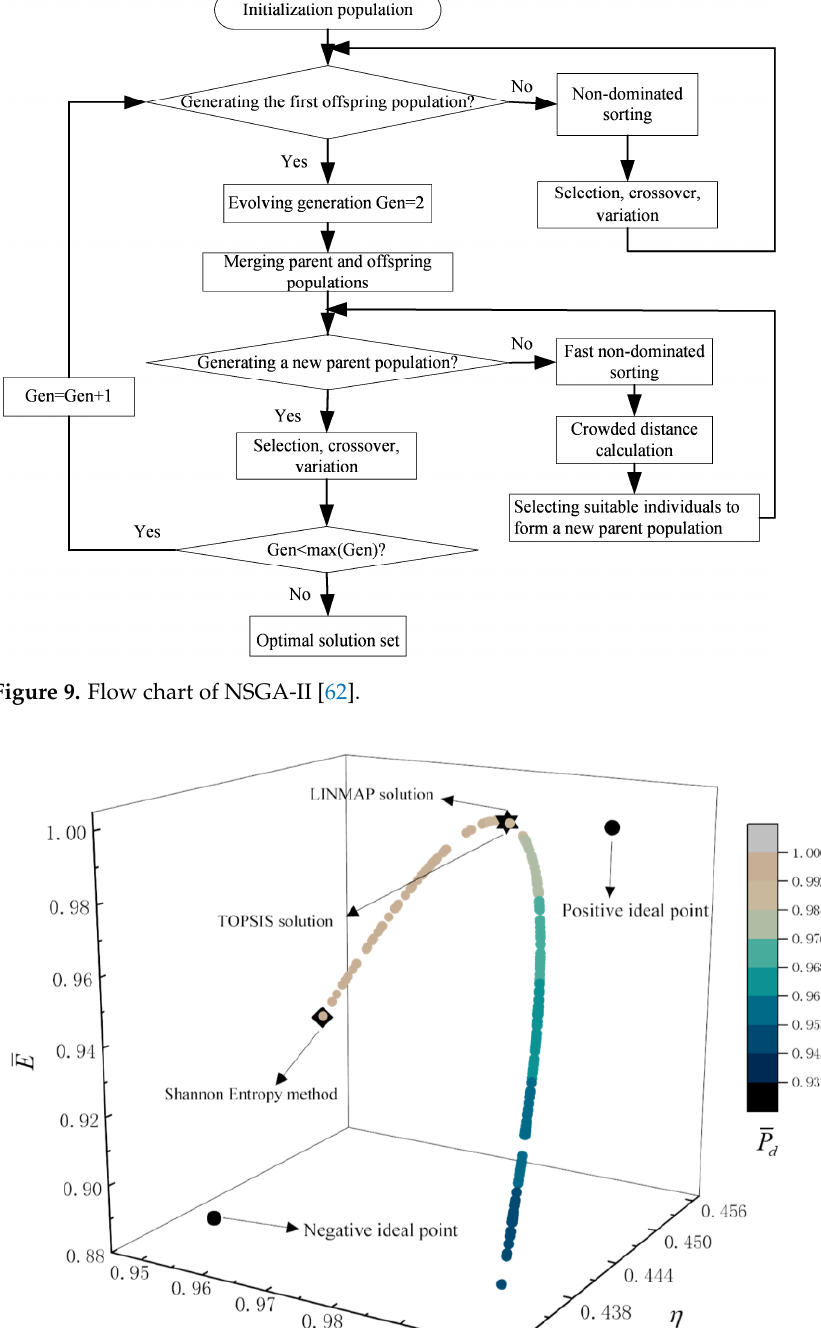
Figure 11. Tri-objective optimization on P